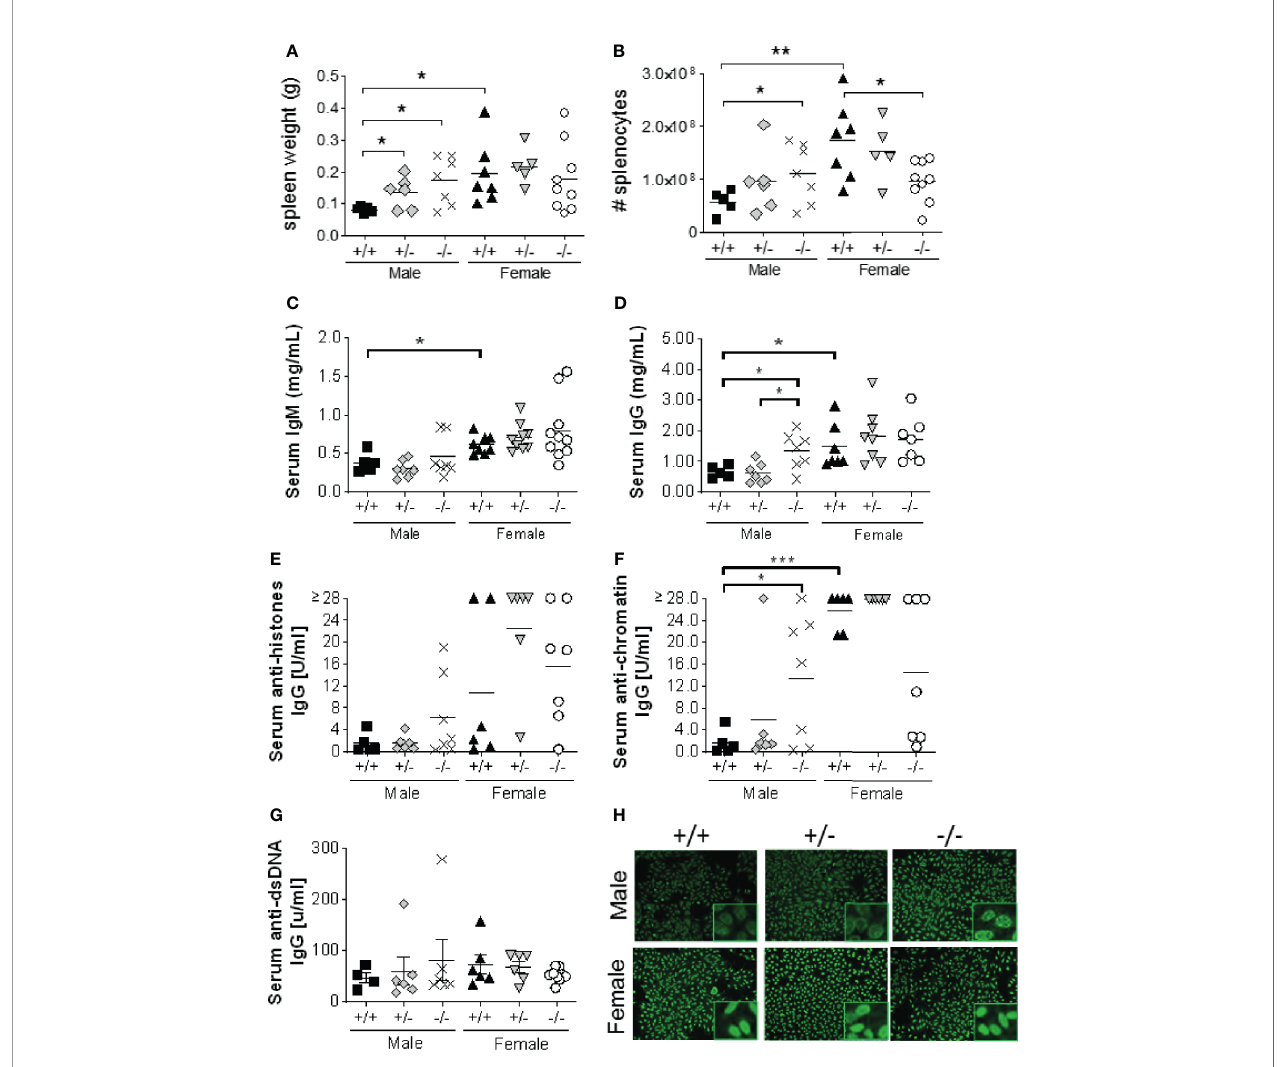
FIGURE 3 | S100a9 -/- male BWF1 mice develop splenomegaly and elevated anti-nuclear autoantibodies. Spleens were harvested from eight month old BWF1 lupus-prone mice. Spleen weight (A) and splenocyte count (B) were measured ( n = 5-11). Each symbol represents one individual mouse, horizontal lines represent mean values. C-G) Serum was obtained from fi ve months old BWF1 lupus-prone mice and serum autoantibody levels were determined by ELISA: serum IgM (C) , serum IgG (D) , anti-histone IgG (E) , anti-chromatin IgG (F) , anti-dsDNA (G) . Each symbol represents one individual mouse ( n = 5-11). (H) Hep2 Assay depicting nuclear and perinuclear antibody staining. Representative pictures shown from 5-11 mice/group. *p < 0.05; **p < 0.01; ***p < 0.001, Student ’ s unpaired t test with Welch ’ s correction. One-way ANOVA: p = 0.21 (A) , p < 0.05 (B) , p < 0.01 (C) , p < 0.01 (D) , p < 0.01 (E) , p < 0.0001 (F) , p = 0.87 (G)